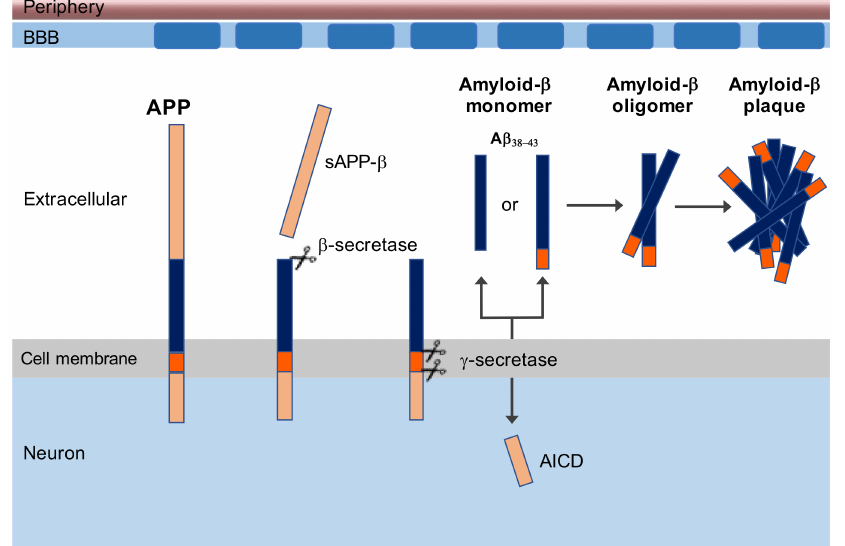
Figure 1. Amyloid-beta plaque generated from amyloid precursor protein (APP). Firstly, the outer- most extracellular fragment of APP is cleaved by β -secretase, and sAPP- β is released extracellularly. The remaining part of APP is subsequently cleaved by γ -secretase, freeing extracellular amyloid- β (A β ) monomer and an intracellular APP domain (AICD). Because γ -secretase has variable cleavage sites, the length of A β will be between 38 and 43 amino acids long. The A β can aggregate into oligomers, and the A β 42–43 will form